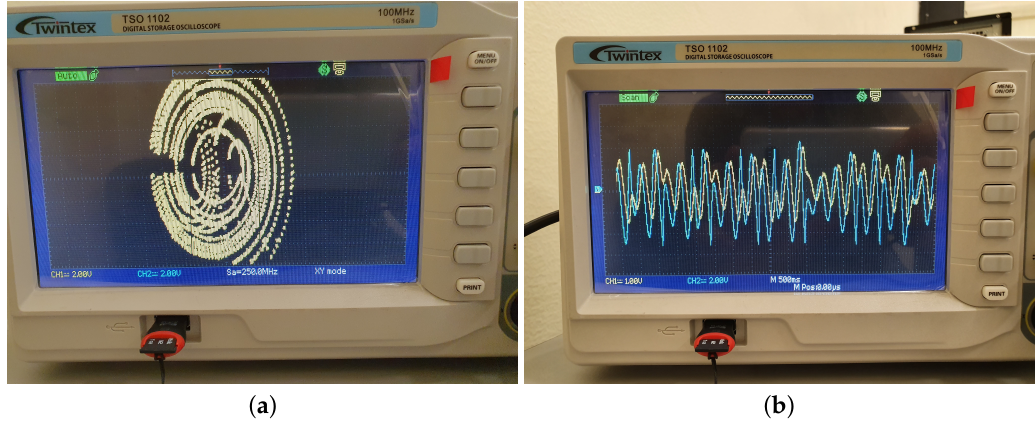
Figure 6. Acquired data from the master system: ( a ) Projection on the plane ( χ 2 , χ 3 ). ( b ) χ 3,3 vs t